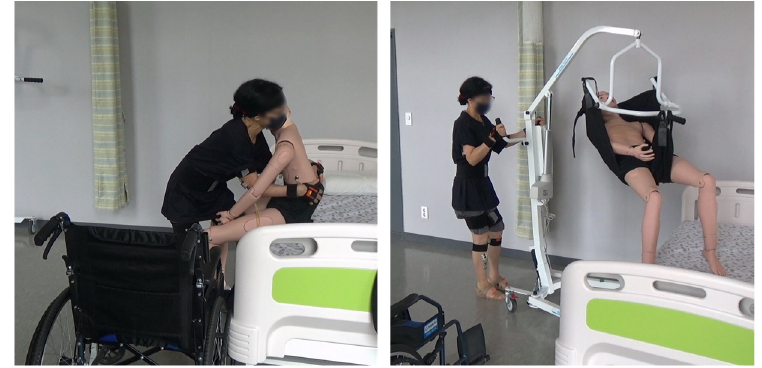
Figure 5. Lifting care task (Left: MC, Right: